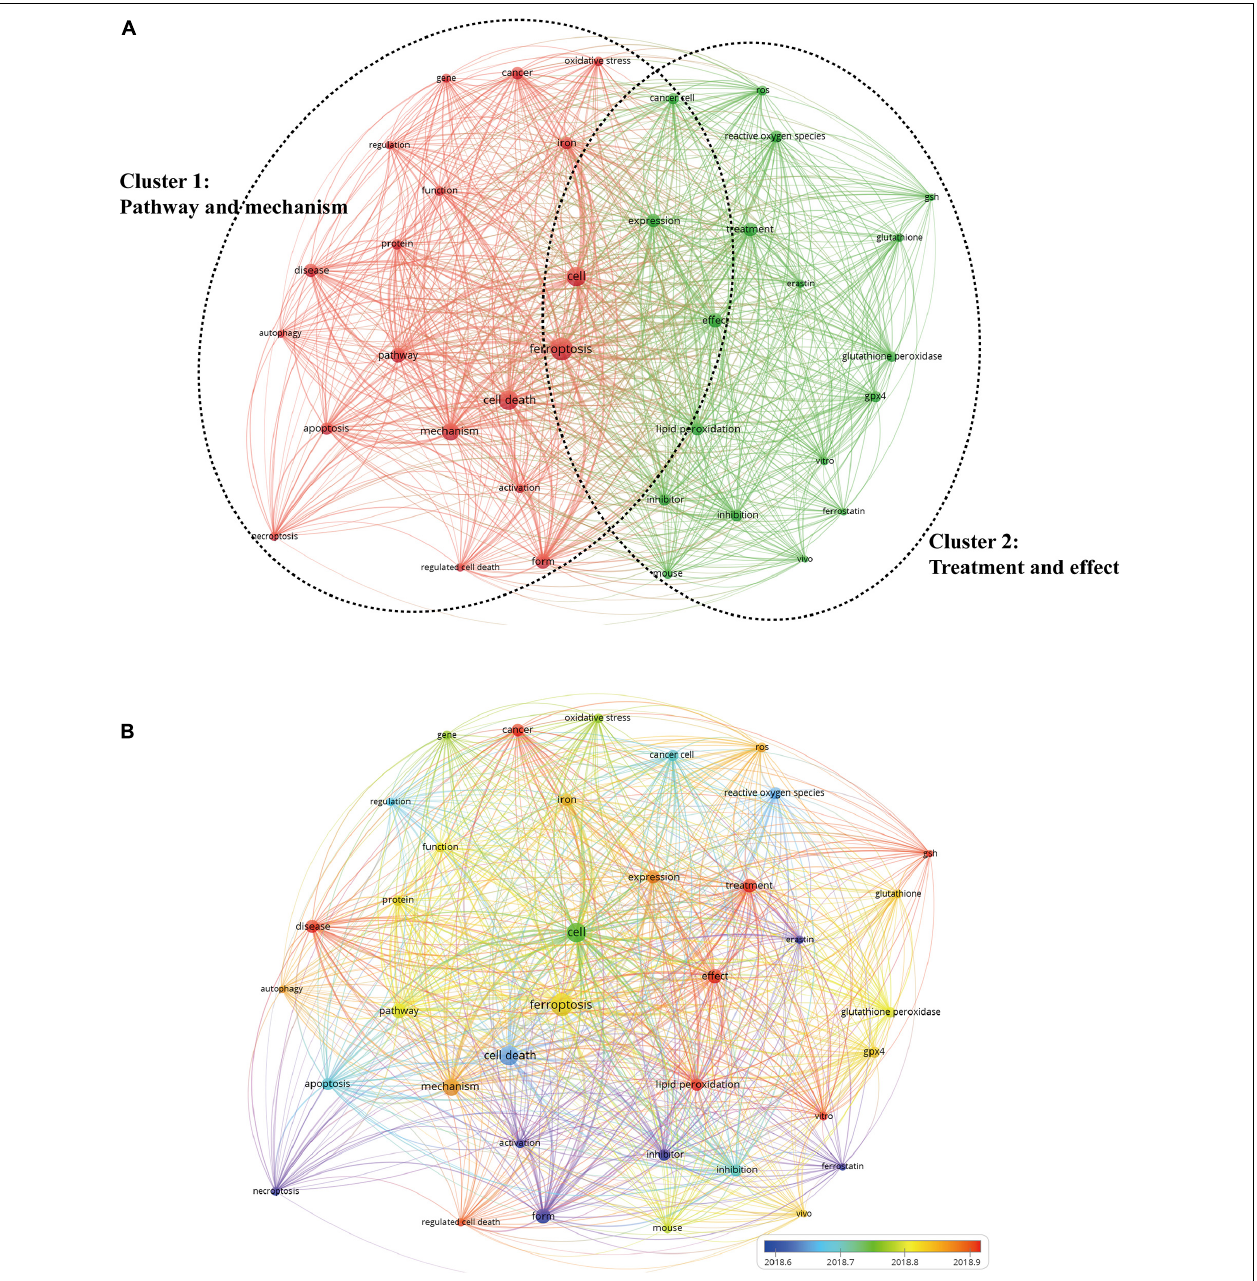
FIGURE 9 | The network visualization map of keywords by VOS viewer. (A) Map of keywords clustering showed 37 keywords with a minimum of 100 occurrences and divided into two clusters. (B) Different colors were applied for each keyword based on their average appearance time in the overlay visualization map. Blue color represented the keywords that appeared relatively earlier than those in yellow and red upon time